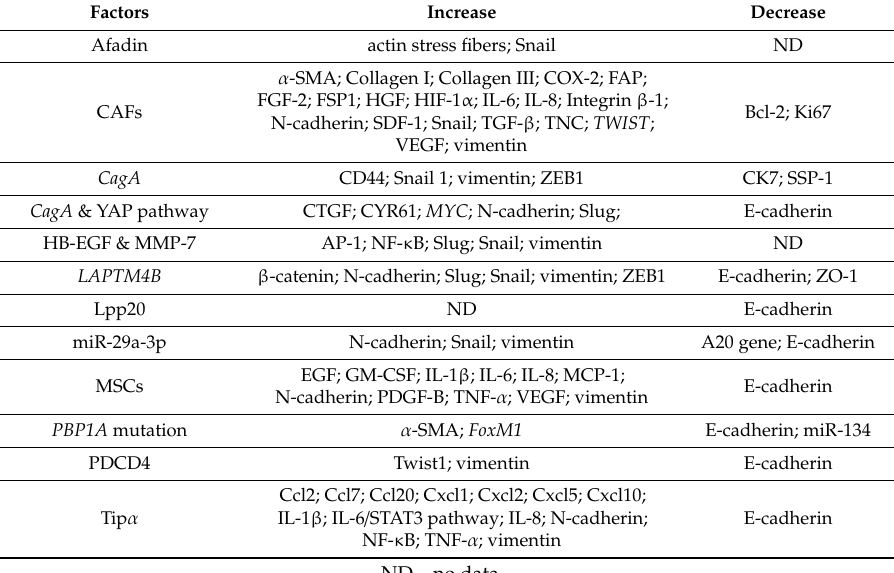
Table 1. Virulence factors and cellular components associated with EMT and H. pylori